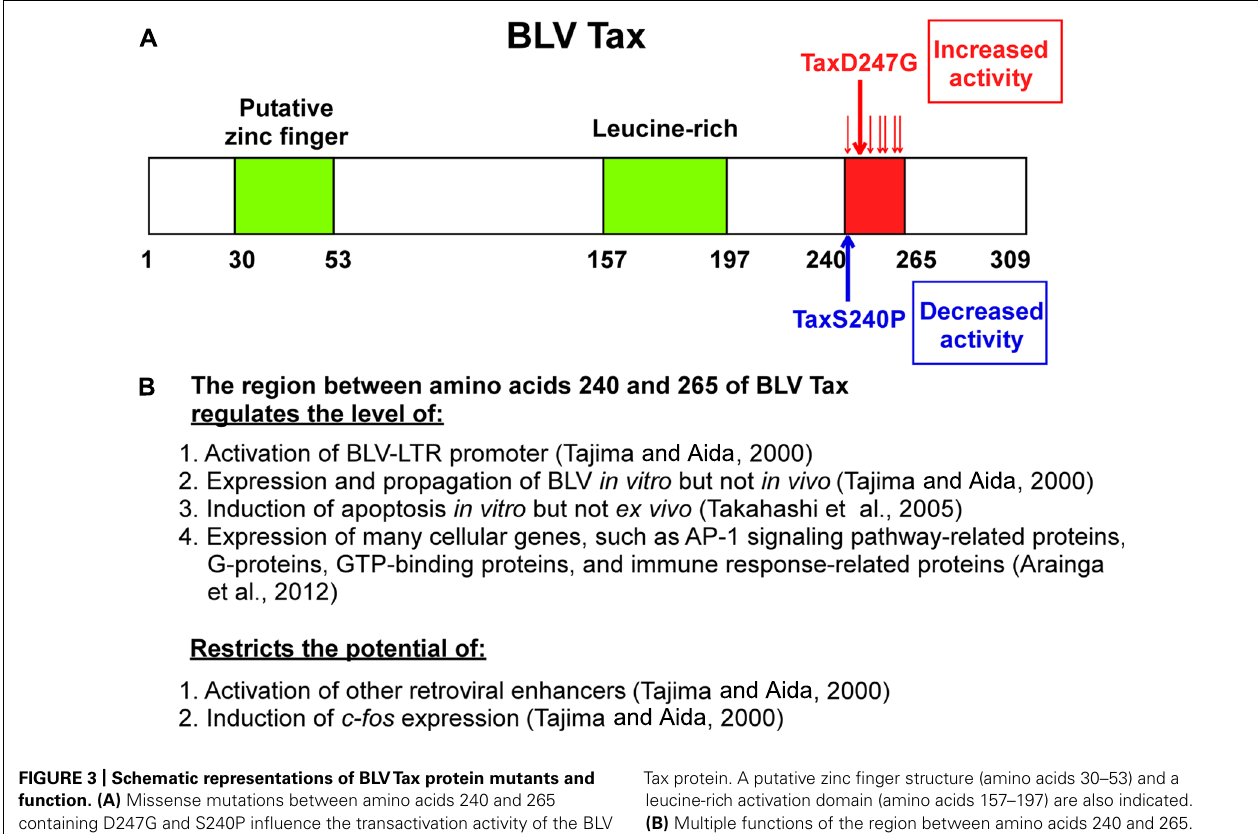
Tax protein. A putative zinc finger structure (amino acids 30–53) and a leucine-rich activation domain (amino acids 157–197) are also indicated. (B) Multiple functions of the region between amino acids 240 and